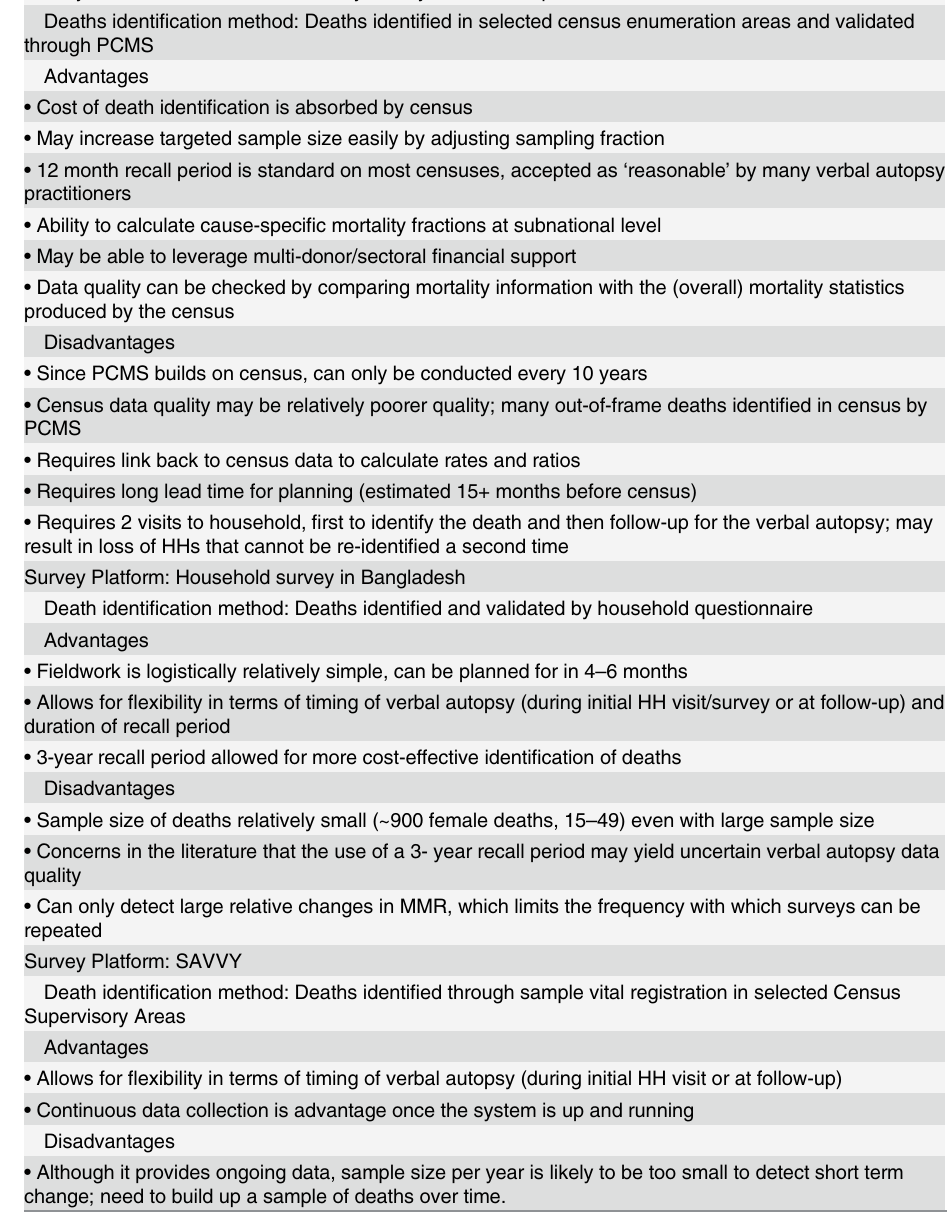
Table 7. Summary of the advantages and disadvantages of different verbal autopsy platforms. Survey Platform: Post census mortality survey in